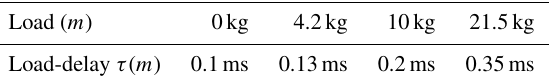
Table 2. Identification of load-dependent